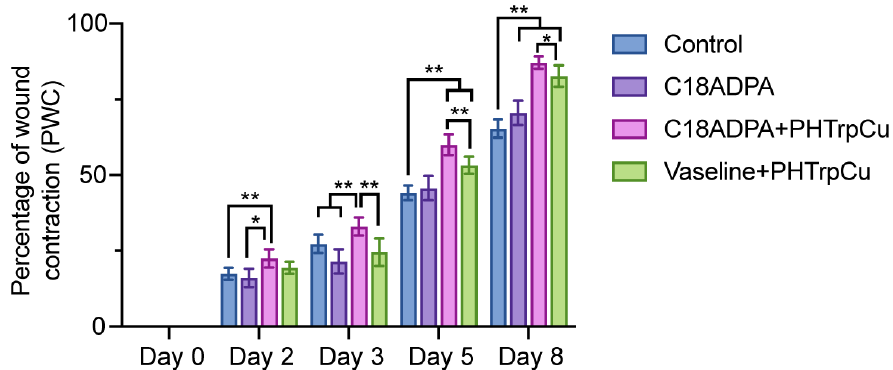
Figure 9. The percentage of wound contraction was calculated based on the results of the animal test ( n = 6). The data was analyzed using a two-way ANOVA (Prism 9.0). ** p < 0.01, * p < 0.05. Skin tissues collected on days 2 and 8 were used for the histological analysis (Figure 10).